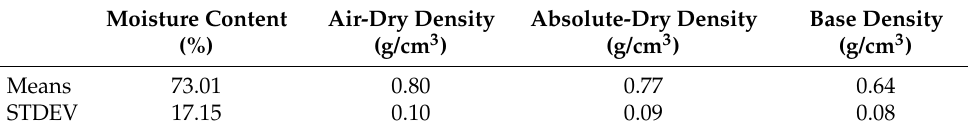
Table 3. The mean values of moisture content and densities of the culm wall.